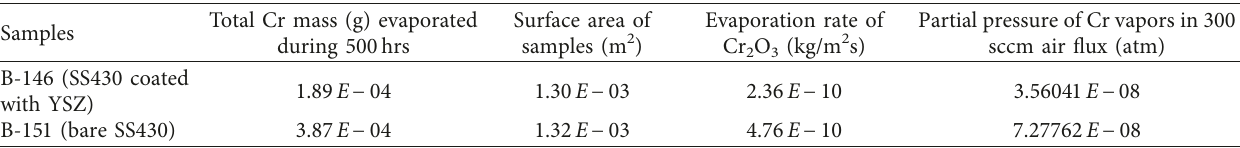
Figure 22: Cr evaporation test images of uncoated and YSZ-coated 430SS 1-inch various intervals for 500h at 800 ° C. Table 5: Concentration of Cr found in the materials deposited in the condensers from the Cr evaporation testing at 800 ° C for 500h.